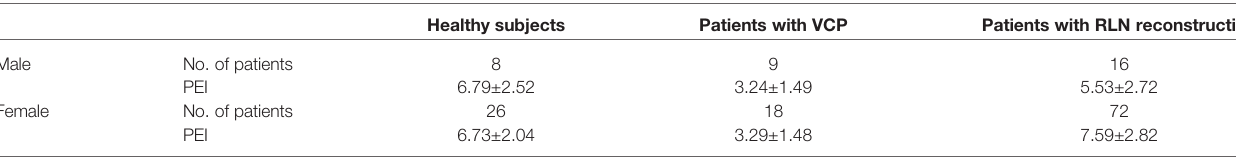
TABLE 3 | Phonation ef fi ciency index in healthy subjects, patients with vocal cord paralysis, and patients who underwent reconstruction of the recurrent laryngeal nerve